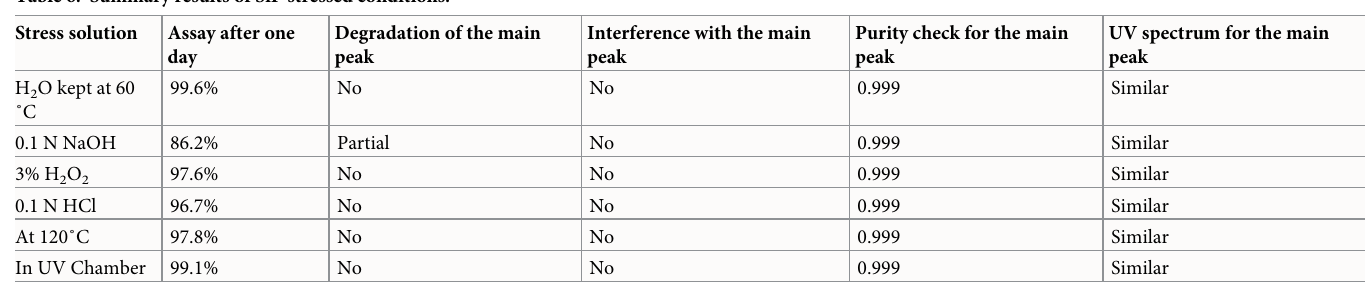
Table 6. Summary results of SiP stressed